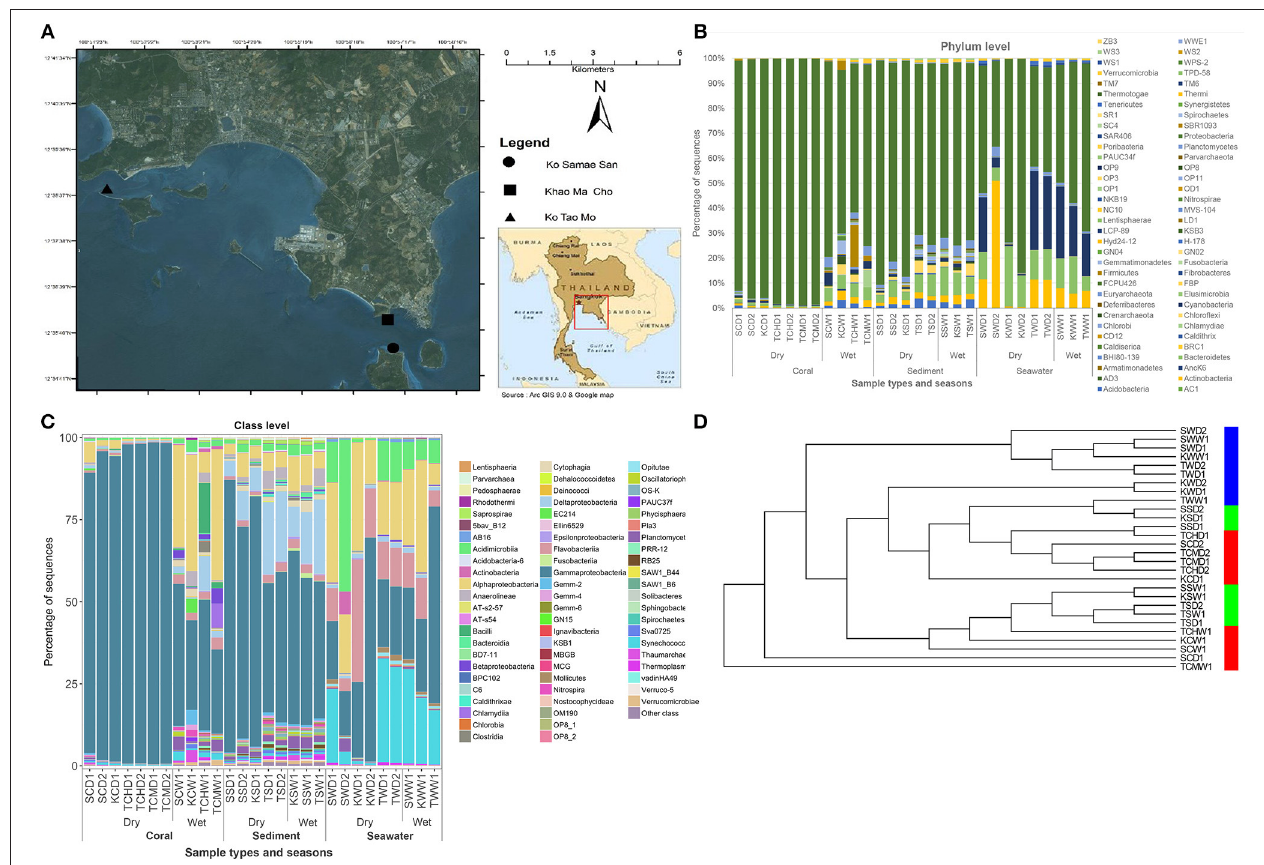
FIGURE 1 | Oceanography map (A) , along the prokaryotic community compositions at phylum (B) and class (C) levels, and the UPGMA cluster analysis (D) , of corals, sediment, and seawater communities, at Ko Samae San, Khao Ma Cho, and Ko Tao Mo fringing reef sites. In panel (C) , other class represents the OTU classes of <